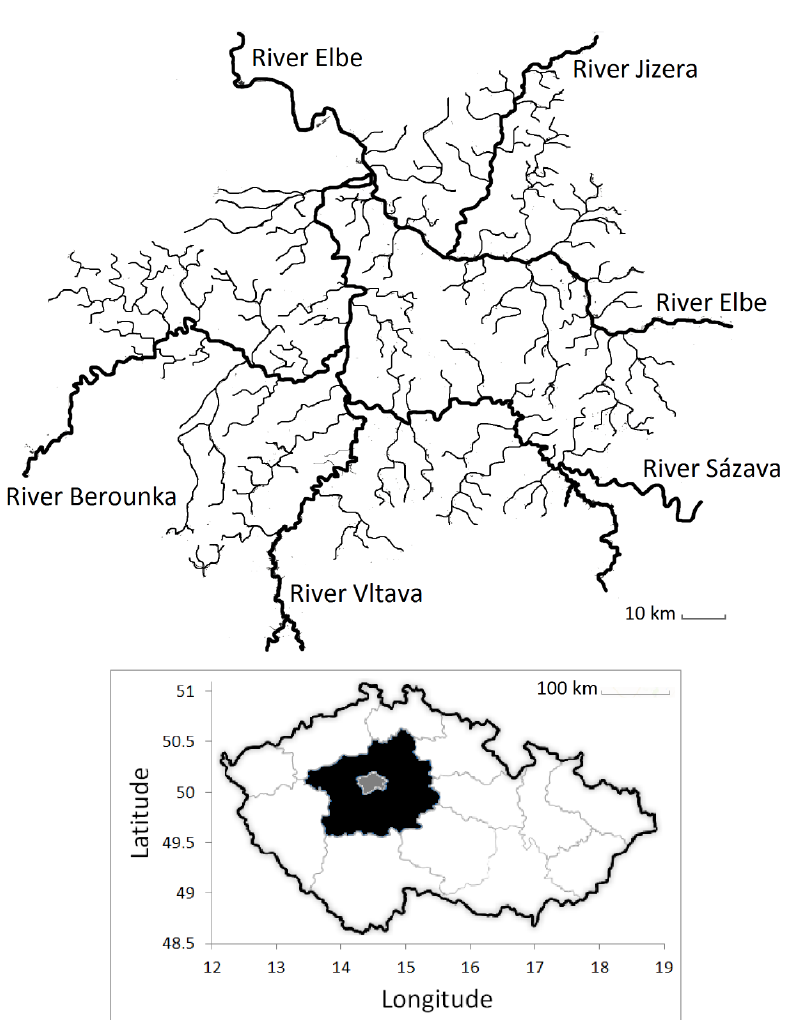
Figure 1. Map of the study area with the highlighted rivers and streams where the anglers reported harvested eels and where fishery managers stocked the eel elvers and yellow eels over the years 2005–2018. The study area is situated in the regions of Prague (gray color) and central Bohemia (black color) in the Czech Republic (49.5°–50.5° N, 13.5°–15.5° E) in Central Europe.